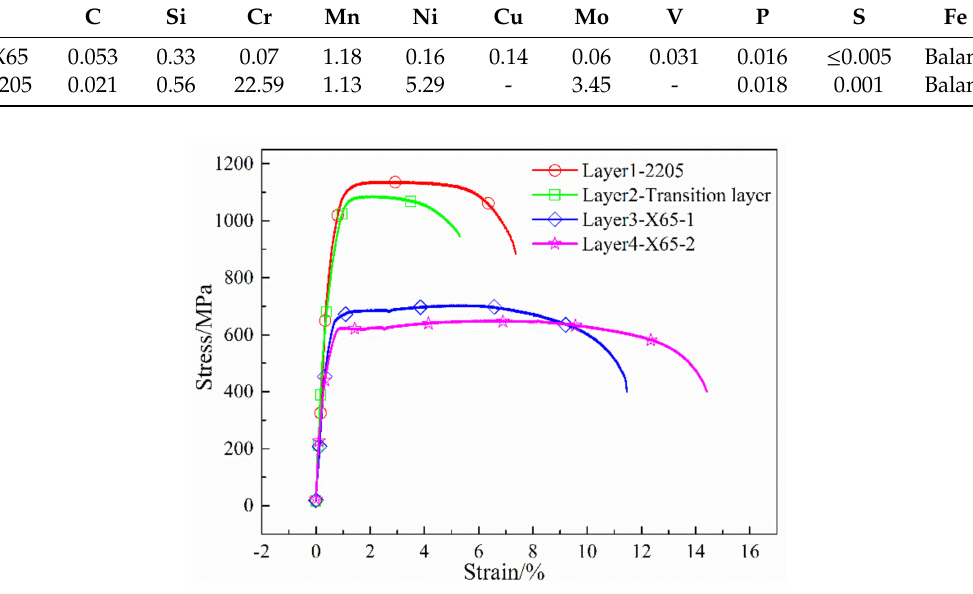
Figure 4. Stress-strain curves of materials for 2205 / X65 plate